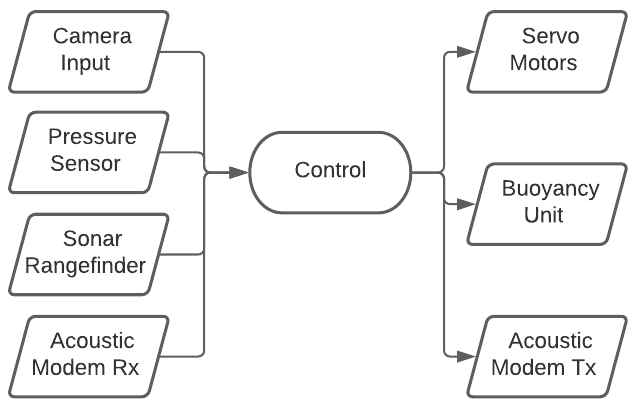
Figure 8. RoboFish Control